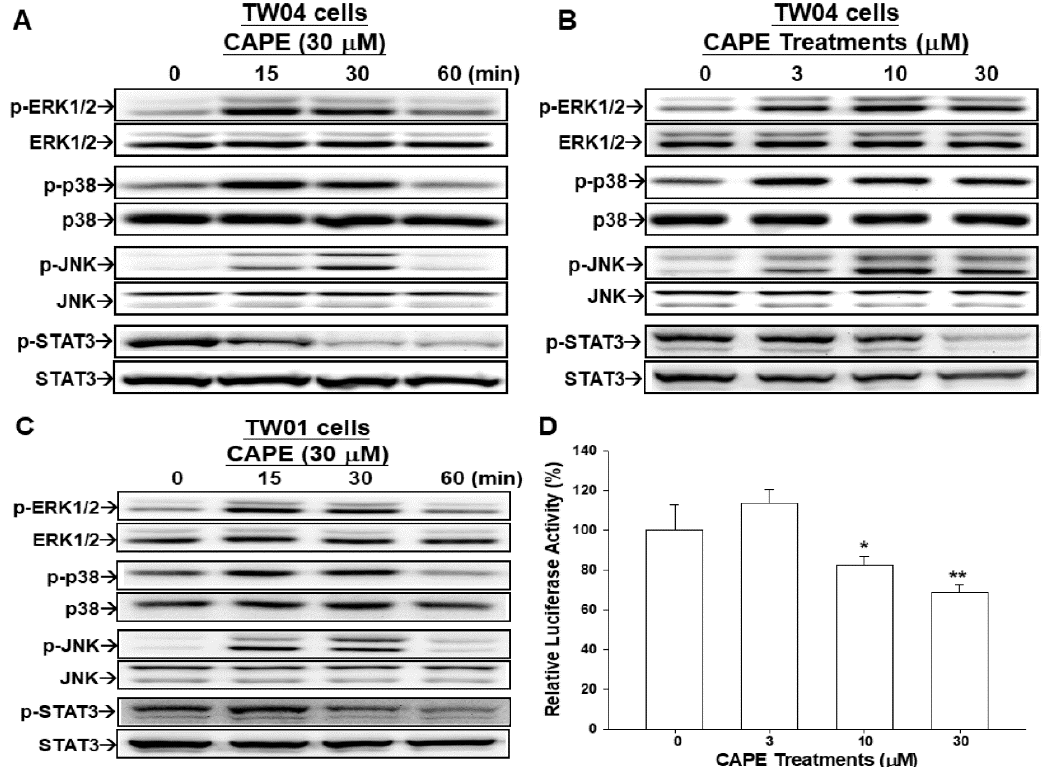
Figure 5. CAPE modulates phosphorylation of MAPK and STAT3 in NPC cells. ( A ) Time course of activities of components of MAPK signal pathway and STAT3 in TW04 cells treated with 30 µ M CAPE. Expressions of ERK, p-ERK, p38, p-p38, JNK, p-JNK, STAT3, p-STAT3, and β -actin were determined by the immunoblotting assay. ( B ) Dose responses of ERK, p-ERK, p38, p-p38, JNK, p-JNK, STAT3, p-STAT3, and β -actin were determined by the immunoblotting assay after 15 min of CAPE treatments in TW04 cells. ( C ) Time course of activities of components of MAPK signal pathway and STAT3 in TW01 cells treated with 30 µ M CAPE were evaluated by immunoblotting assay. ( D ) The pSTAT3-TA-Luc reporter vectors were transfected into TW04 cells for 24 h, and cells were then treated by indicated concentrations of CAPE for 24 h. Data were presented as the mean percentage of luciferase activity induced by the CAPE treatment relative to the control solvent-treated group ( ± SE, n = 6). (* p < 0.05, ** p < 0.01).